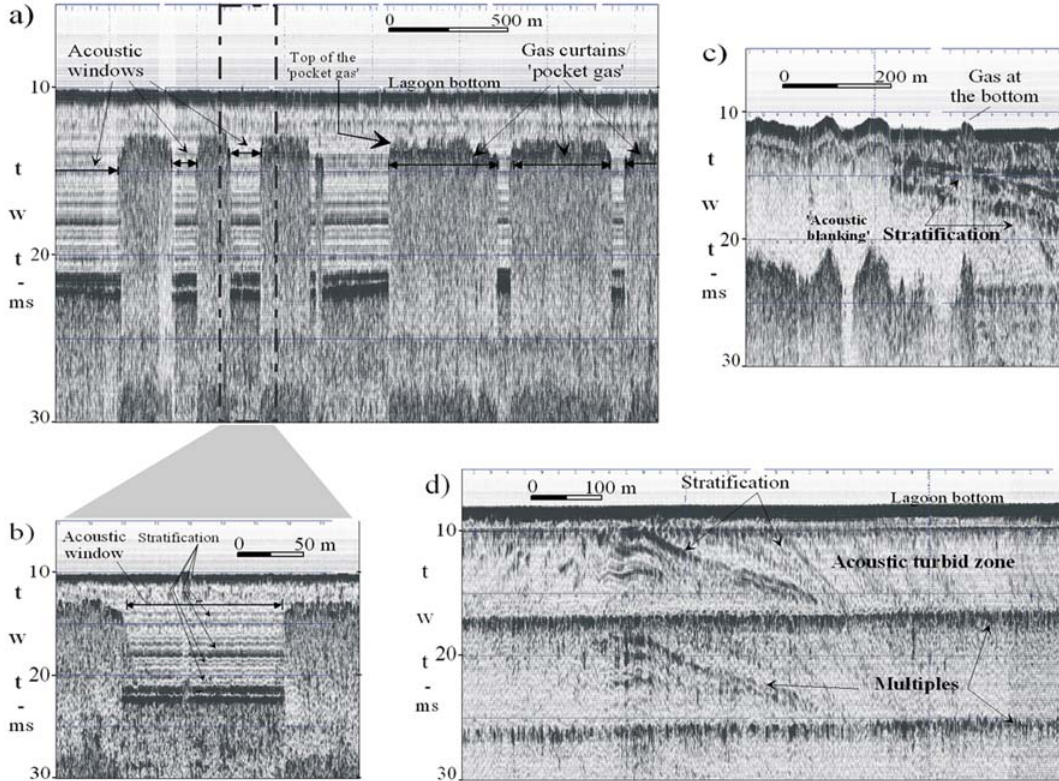
Fig. 2 – Acoustic anomalies from seismic line 4 (see Fig. 1 for location): a) intercalation of ‘gas curtains’ with ‘acoustic windows’; b) zoom of the dashed part of figure 2a; c) record with ‘acoustic blanking’ and gas at the lagoon bottom; d) detail of an ‘acoustic turbid zone’ showing sedimentary stratification. Depths to water surface in two-way traveltime, in milliseconds (ms).